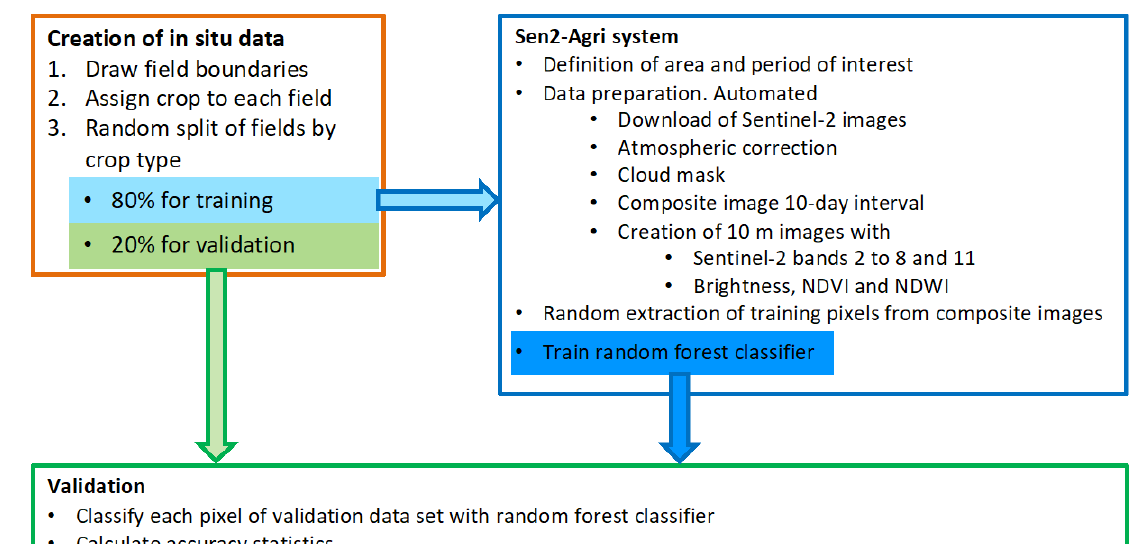
Figure 1. Overview of the